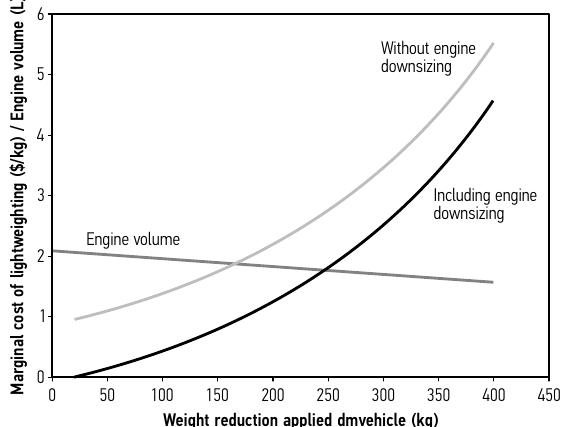
Fig. 15. Marginal cost of lightweighting with and without an offset induced by considering the reduction of engine size possible to maintain the same acceleration level for a lighter